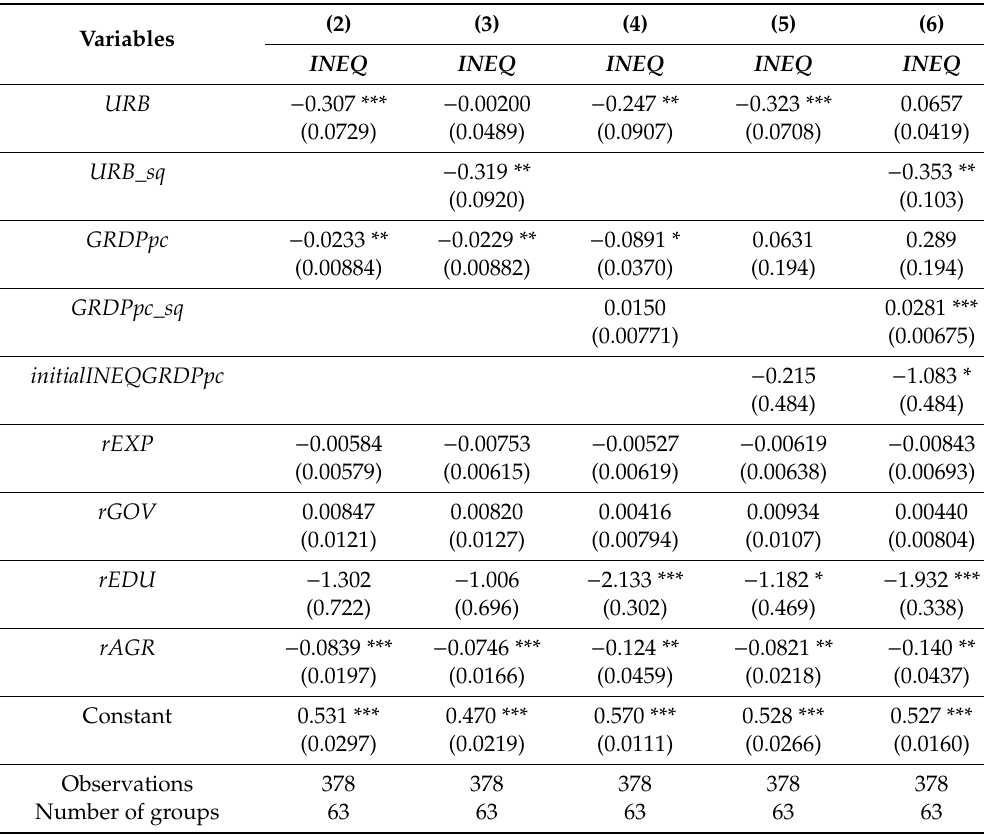
Table 6. Results of Driscoll and Kraay